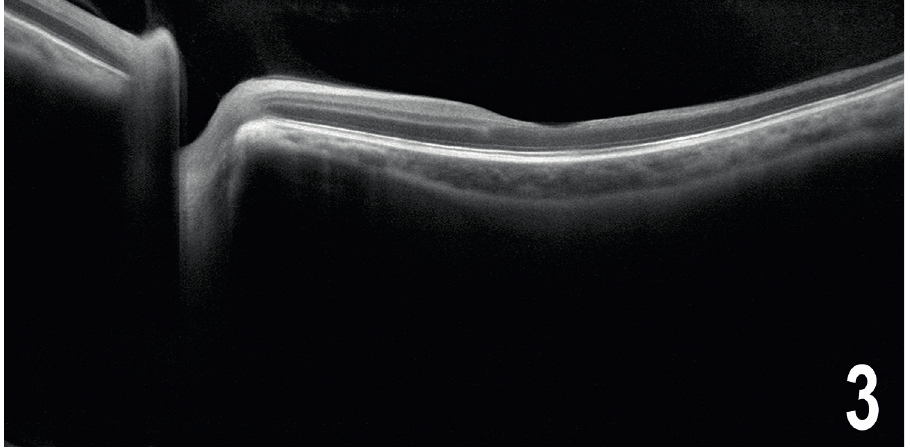
Figure 3. Optical coherence tomography at first visit demonstrate corresponding area of inner retinal thinning at macula temporally.